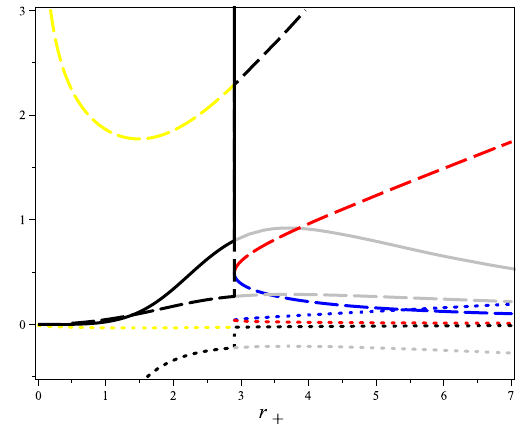
Fig. 11 The temperature (dotted line), heat capacity (solid line) and free energy (dashed line) as a function of r + for c 1 = − 0 . 25 ,α = − 0 .